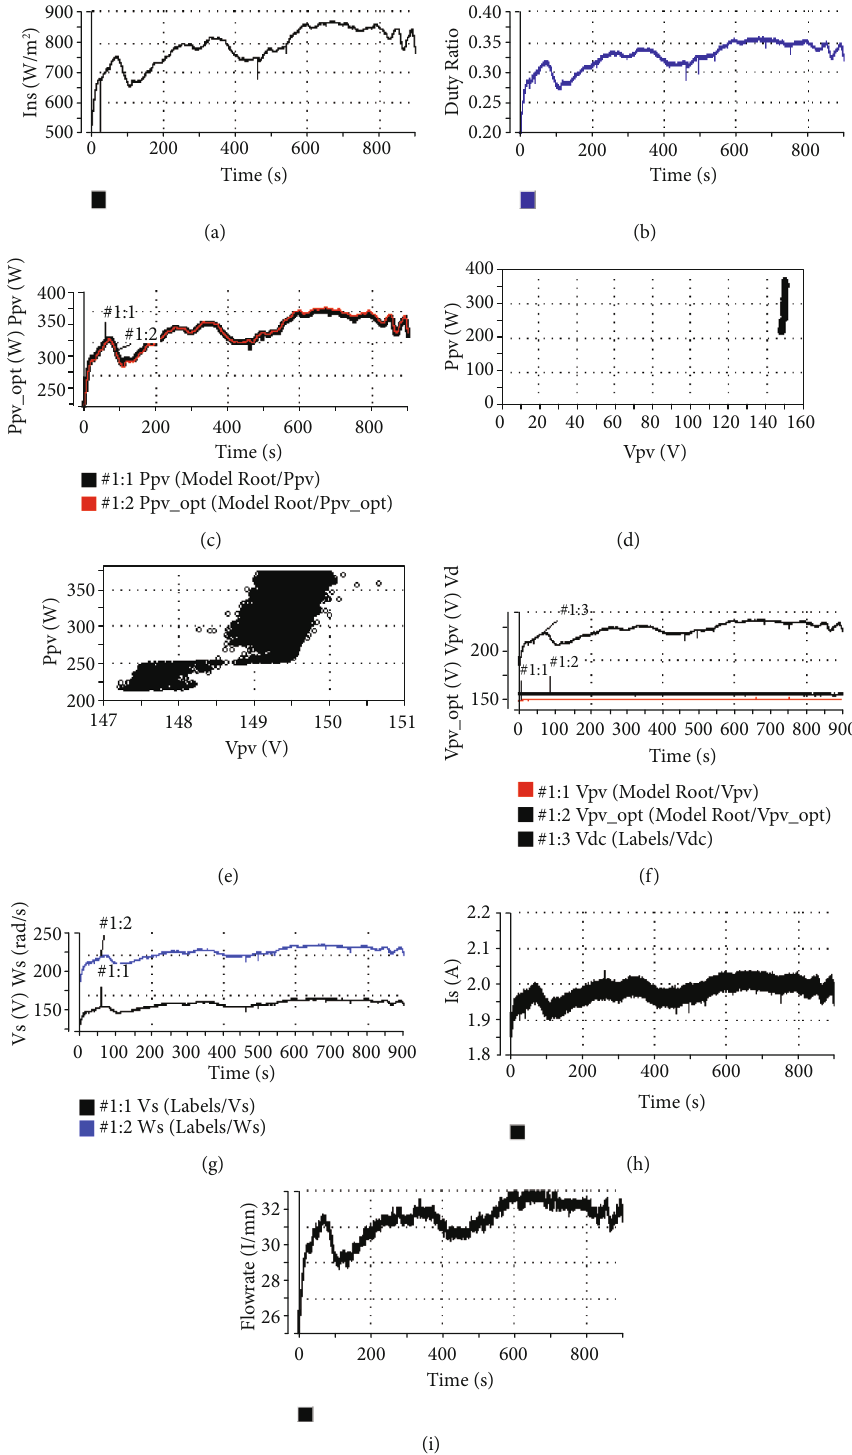
Figure 14: Experimental results of SVPWPS under constant temperature and arbitrary scenario for insolation: (a) evolution of the insolation variation; (b) evolution of the duty cycle; (c) evolution of input and optimal powers; (d) movement of MPP versus the optimum voltage; (e) a zoom of the movement of MPP versus the optimum voltage; (f) evolution of the input and output voltages; (g) stator voltage and pulsation response; (h) stator current response; (i) fl ow rate